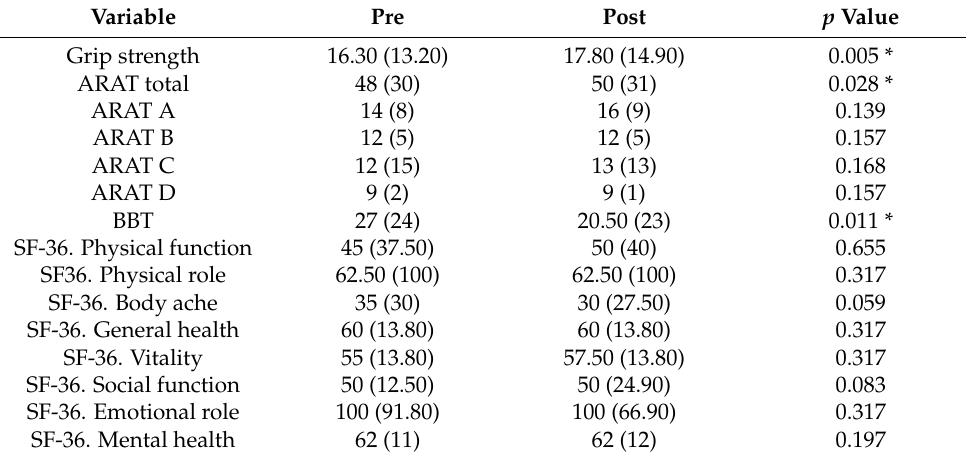
Table 1. Comparison Outcome measures.